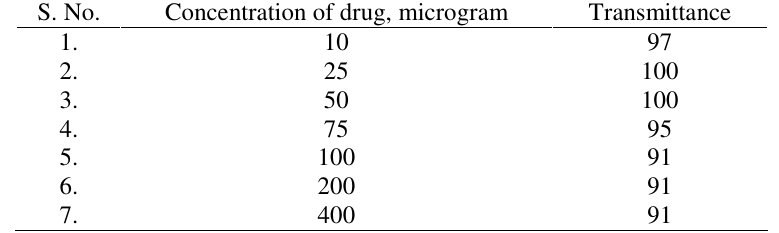
Table 4. Effect of ethyl acetate fraction of Thevetia peruviana on human red blood cell S.